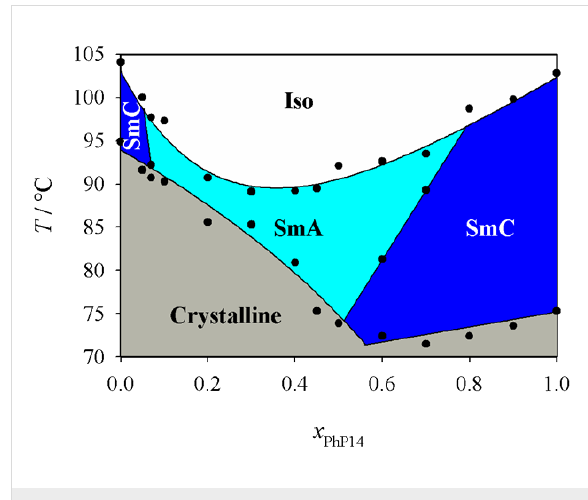
Figure 9: Phase diagram of the system 6PhPz / PhP14 . Over a broad temperature region only the SmA phase is stable, although the two pure compounds exhibit only SmC